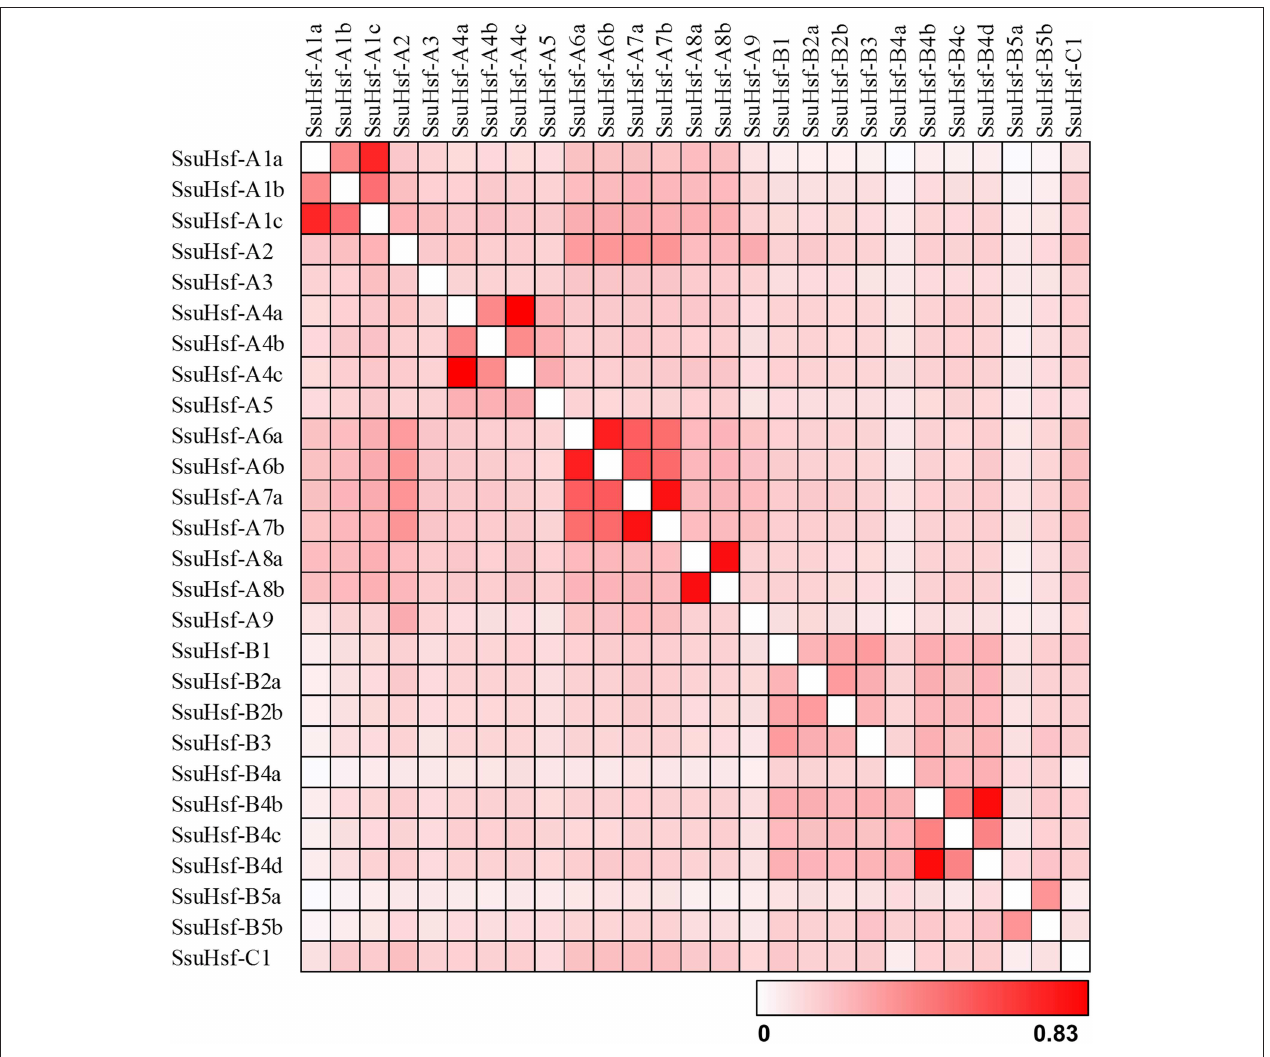
FIGURE 3 | Sequence identity of SsuHsf proteins. Amino acid identity among SsuHsf proteins was analyzed in pairwise fashion.